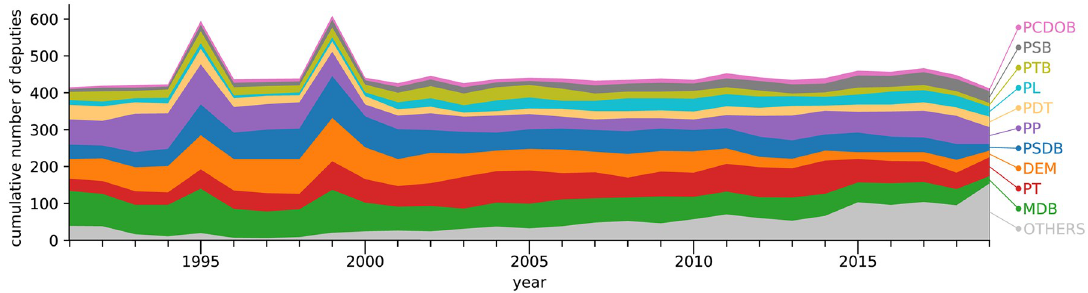
Fig 4. Number of seats of political parties as observed in the Brazilian Chamber of Deputies between 1991 and 2019. The number of deputies from nontraditional parties (“others”) clearly increasing along time. Only the deputies in the largest component of the network were